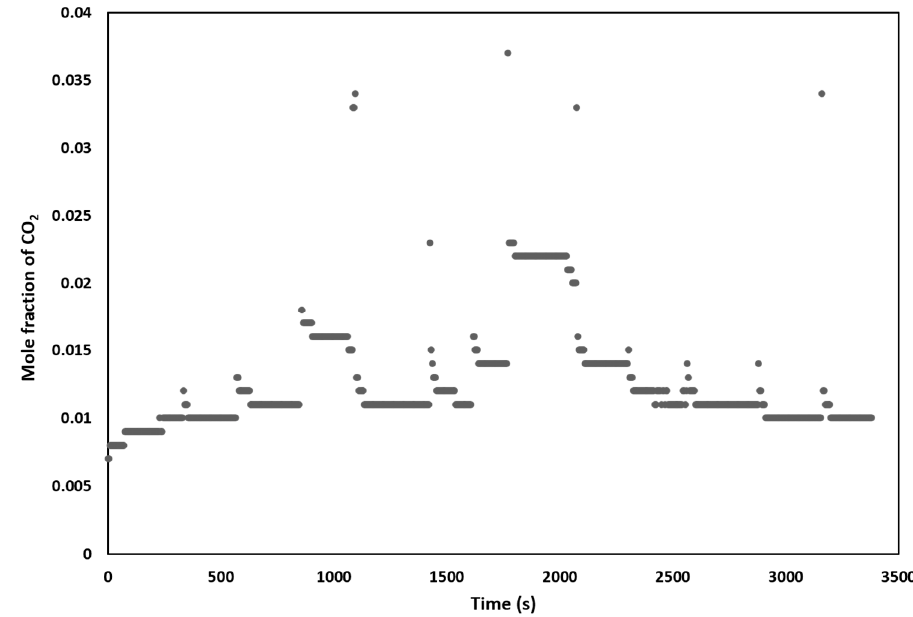
Figure 21. Results of CO 2 measurements during experimentation.